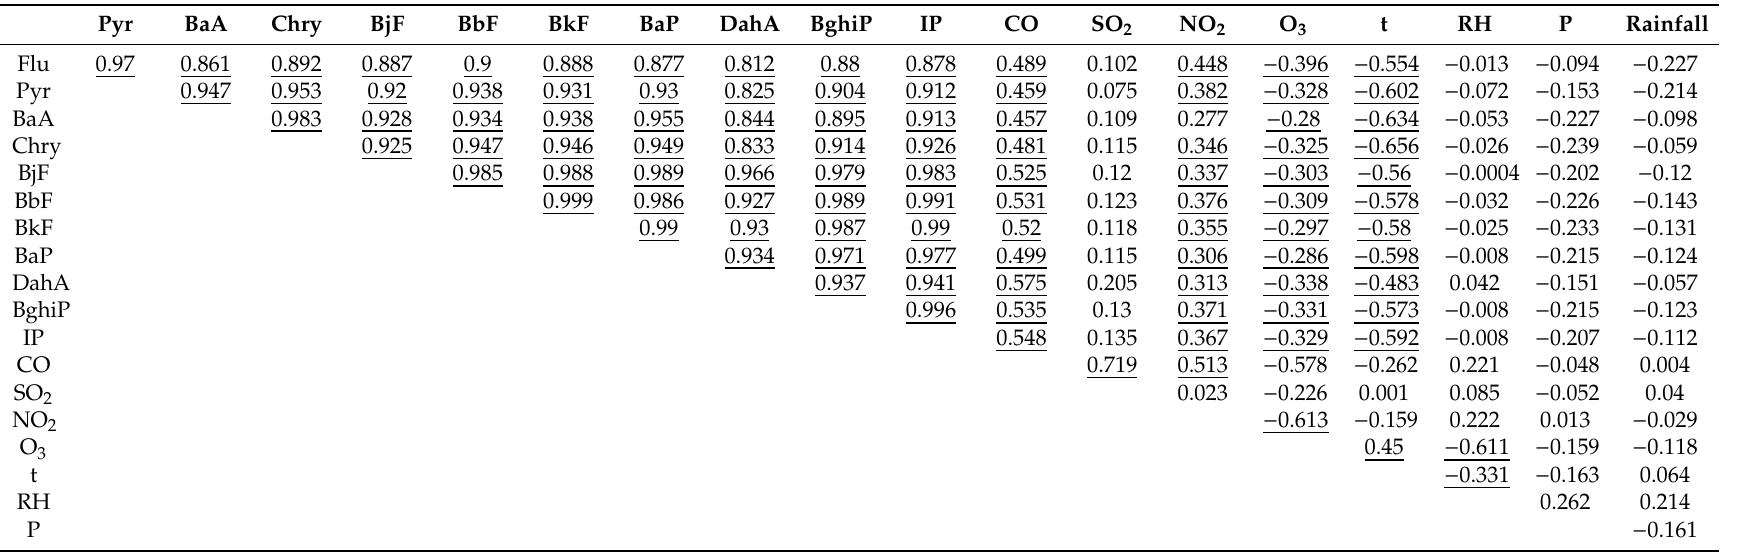
Table 7. Spearman’s correlation coe ffi cients between PAHs, gaseous pollutants, and some meteorological parameters during the warm